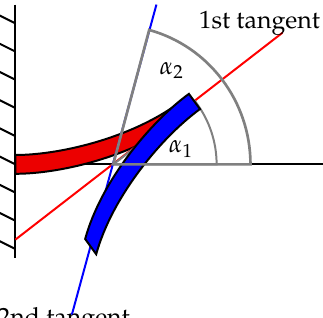
Figure 7. Definition of the first and second tangent angle, α 1 and α 2 , respectively, with respect to the 2nd-order cantilever